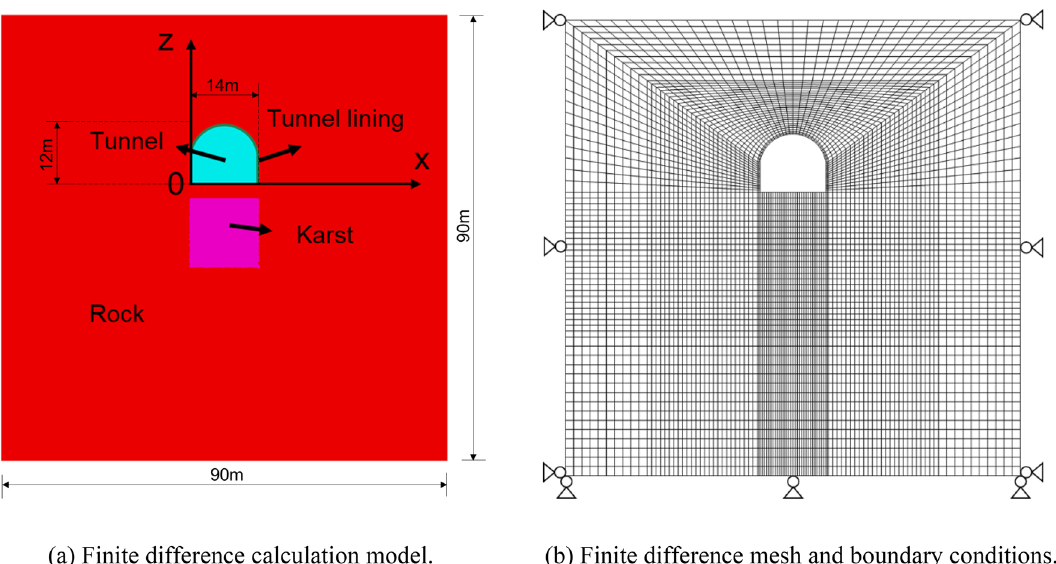
Figure 7. Finite difference model and